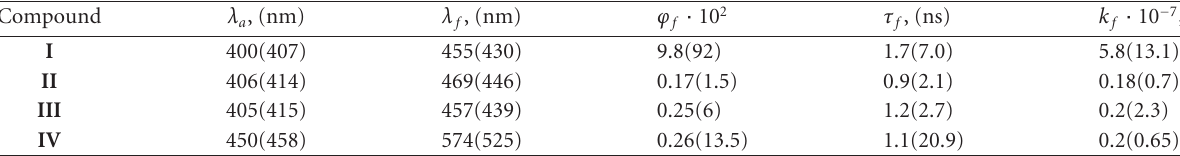
Table 2: The maxima of absorption ( λ a ) and fluorescence ( λ f ) spectra, fluorescence quantum yields ( ϕ f ) and lifetimes ( τ f ), and the fluo- rescence rate constants ( k f ) of I – IV in ethanol at 295K and 77K. Compound